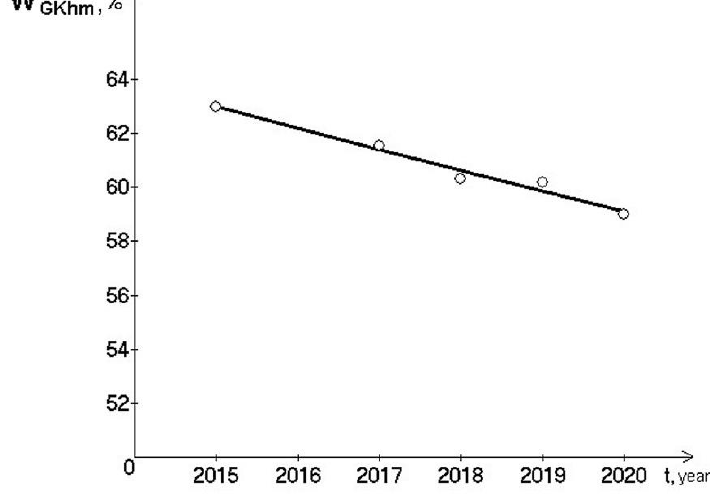
Fig. 1. The dependence describing the actual (○) and theoretical (—) dynamics of wear and tear of garbage trucks in the Khmelnytskyi region in